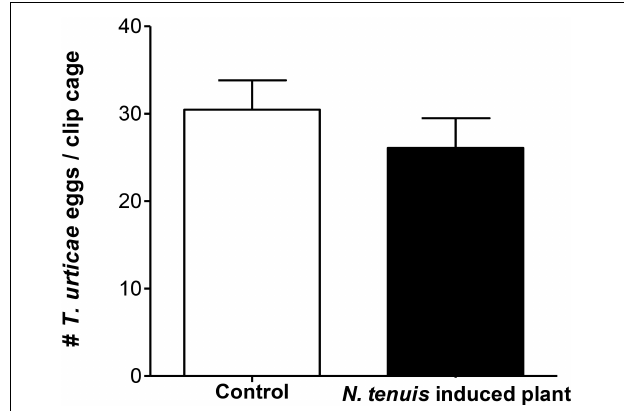
FIGURE 3 | Number (mean ± SE) of Tetranychus urticae females per tomato plant in a glasshouse experiment comparing the mite development on N. tenuis -punctured tomato plants in comparison to intact tomato plants (Control). Bars with different letters are significantly different (GLMM, repeated measures; P <